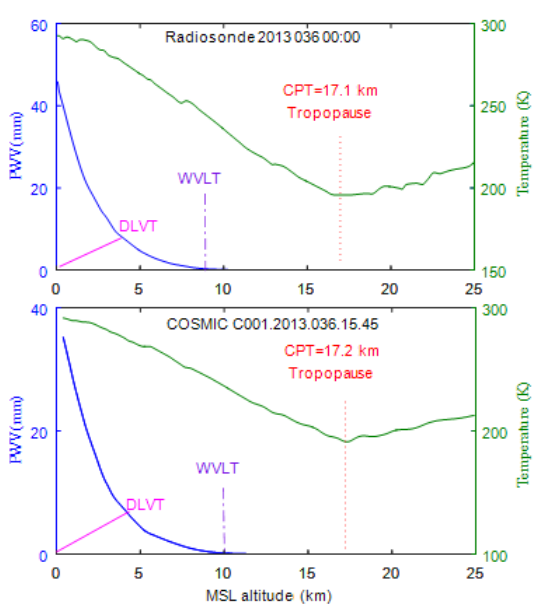
Figure 3. The top of the water vapor layer and the top of the water vapor dense layer obtained by radiosonde and COSMIC